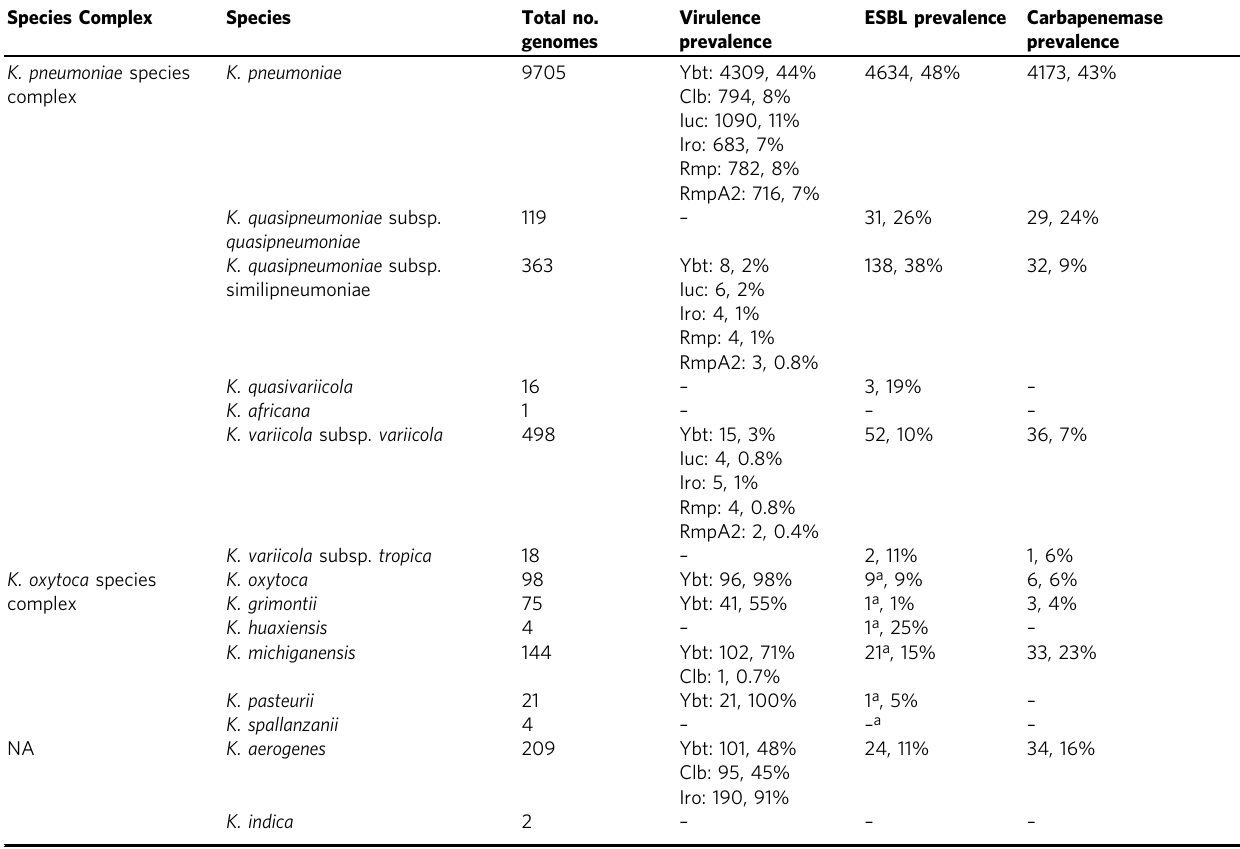
Table 2 Prevalence of virulence loci, ESBL and carbapenemase genes in non-redundant Klebsiella genomes. Species Complex Species Total no.